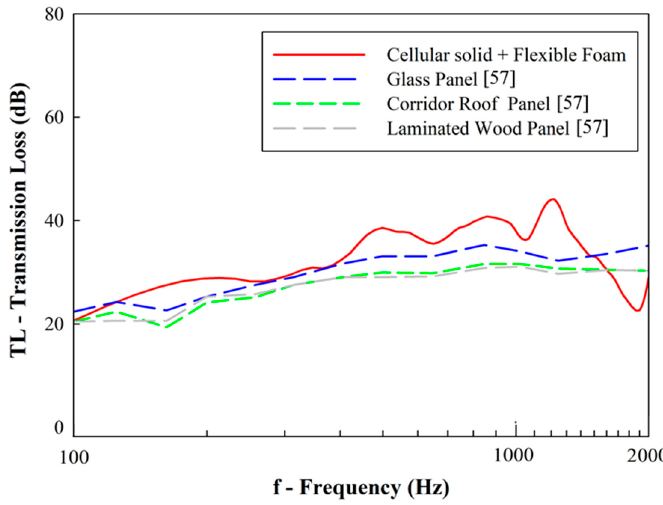
Figure 20. Transmission loss comparison: designed cellular solids vs. materials used in train vehicle fabrication.